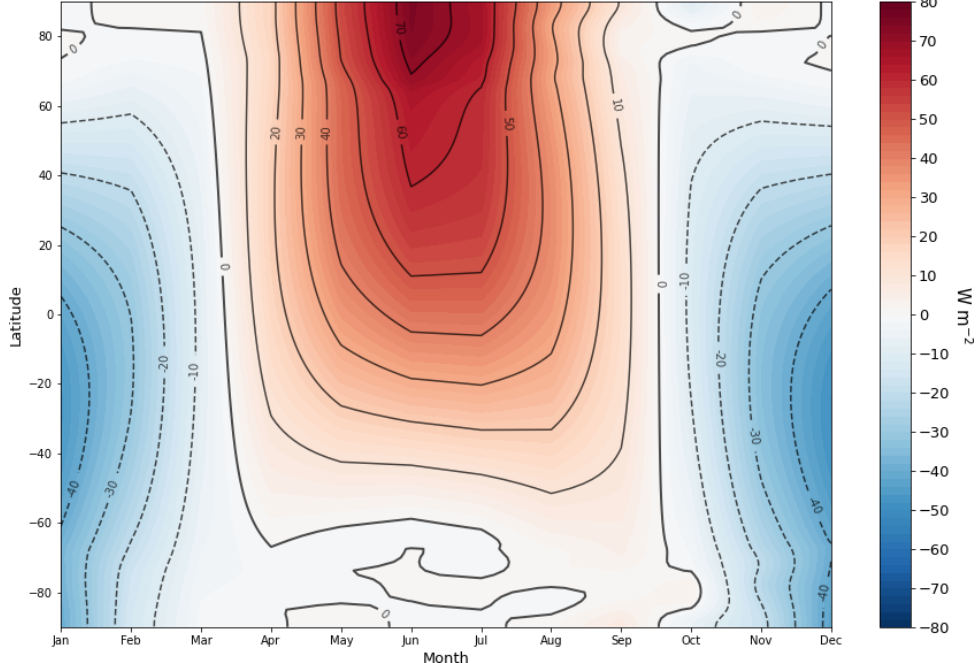
Figure 1. Monthly insolation anomalies at LIG compared to PI. The lengths of months are adjusted using a “fixed-angular” definition following Bartlein and Shafer (2019) (see Sect.